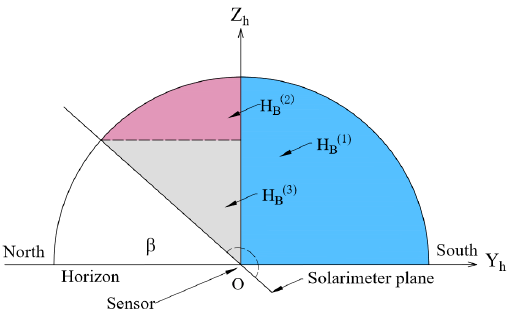
Figure 30. Schematic diagram for the calculation of ℎ (cid:3046) in Burek’s paper [7].